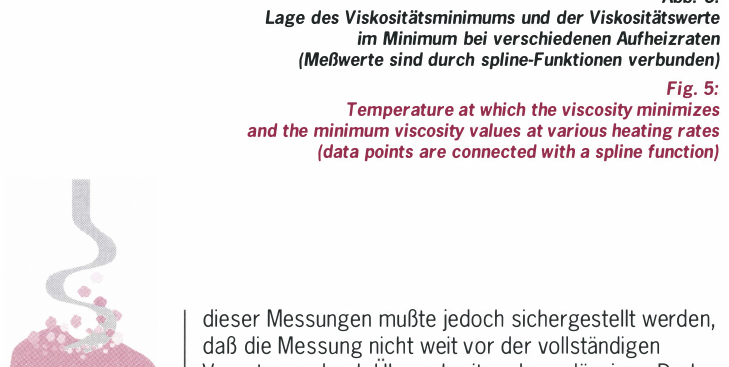
Fig. 5: Temperature at which the viscosity minimizes and the minimum viscosity values at various heating rates (data points are connected with a spline